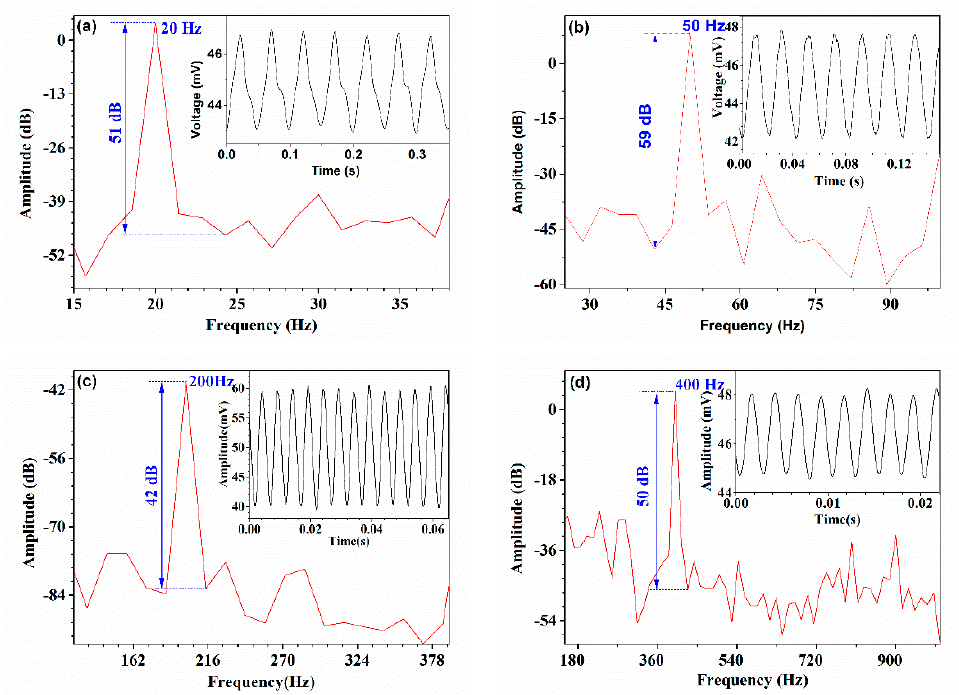
Figure 7. Demodulation of the vibration frequency based on the time-domain spectrum of the ouput voltage signal of the HBF driven by acoustic wave with different frequencies of ( a ) 20 Hz, ( b ) 50 Hz, ( c ) 200 Hz, and ( d ) 400 Hz, respectively.